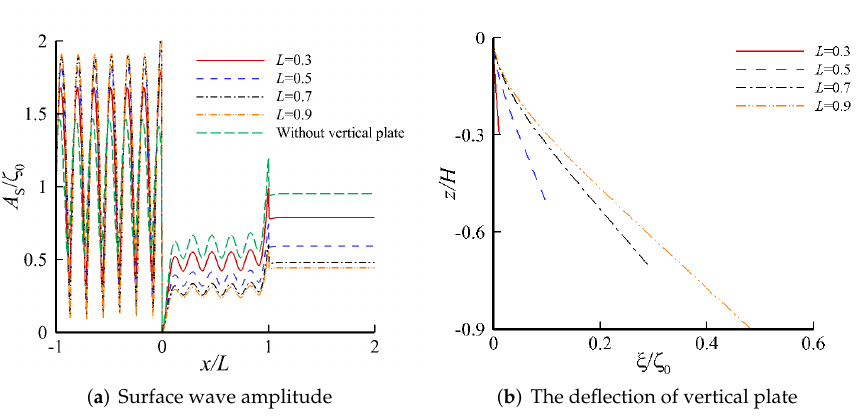
Figure 4. Wave amplitudes A S ( x ) and deflection of vertical plate ξ ( z ) for the different length of vertical plate L .